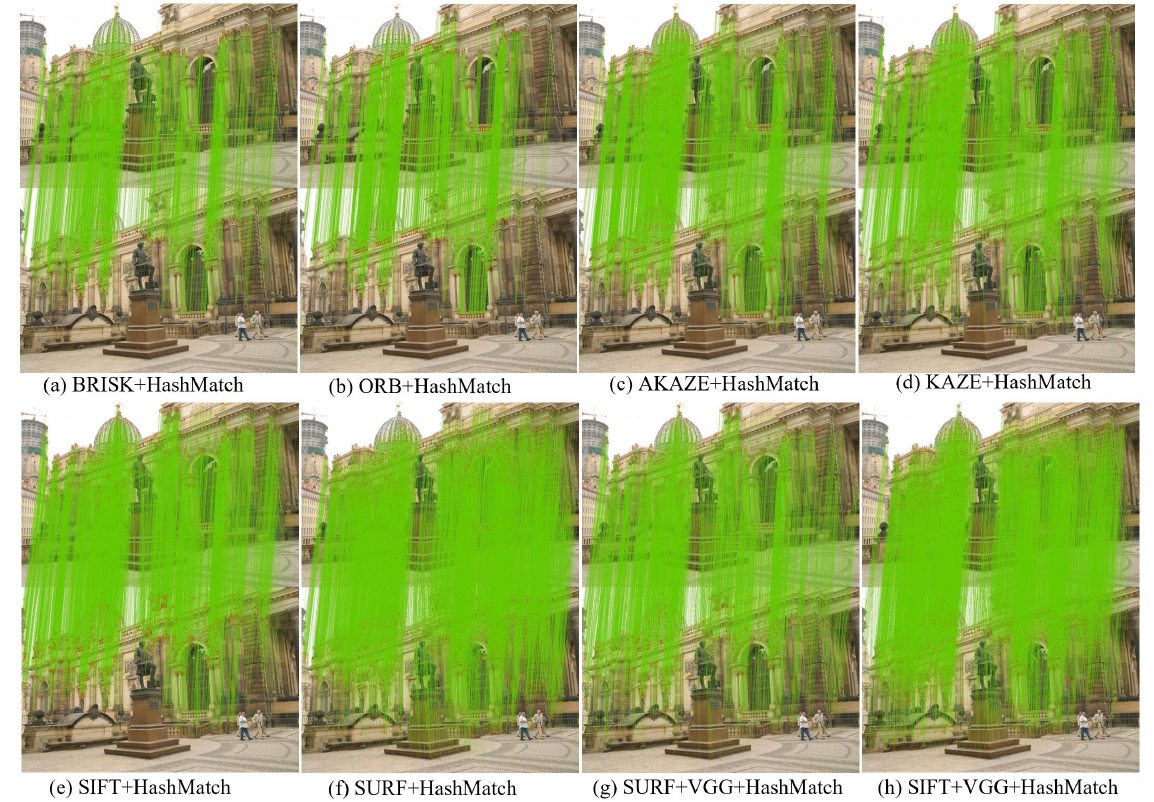
Figure 9. Feature matches of the Semper sequence, where the combination of “SURF + HashMatch” has the highest number of correct feature correspondences. Again, this proves the validity of the HashMatch method. Table 2. Statistical results (correct matches) of the Semper sequence of Strach’s dataset, where HM represents HashMatch, “SURF + VGG” represents SURF detector and VGG descriptor, and “SIFT + VGG” represents SIFT detector and VGG descriptor.